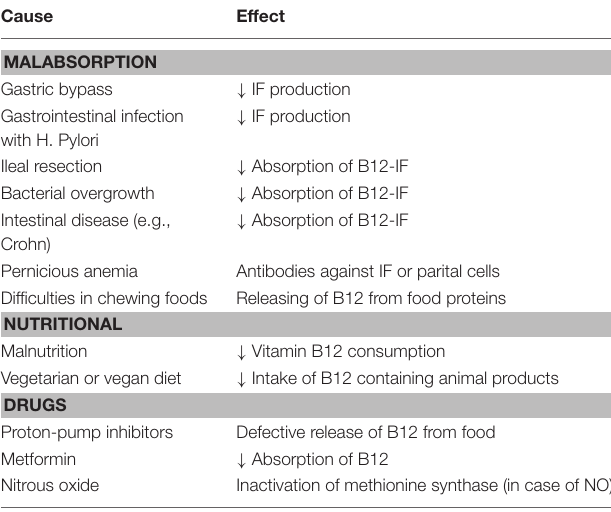
TABLE 1 | Causes of acquired vitamin B12